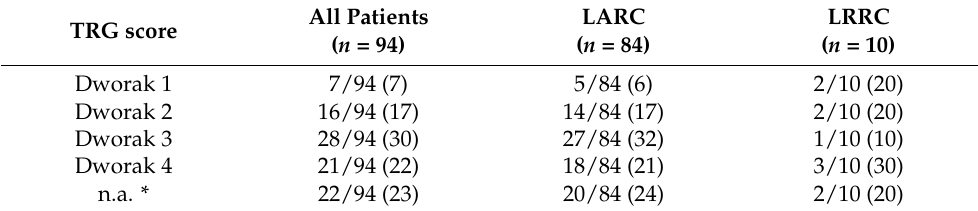
Table 3. Tumor regression grading after curative resection according to Dworak